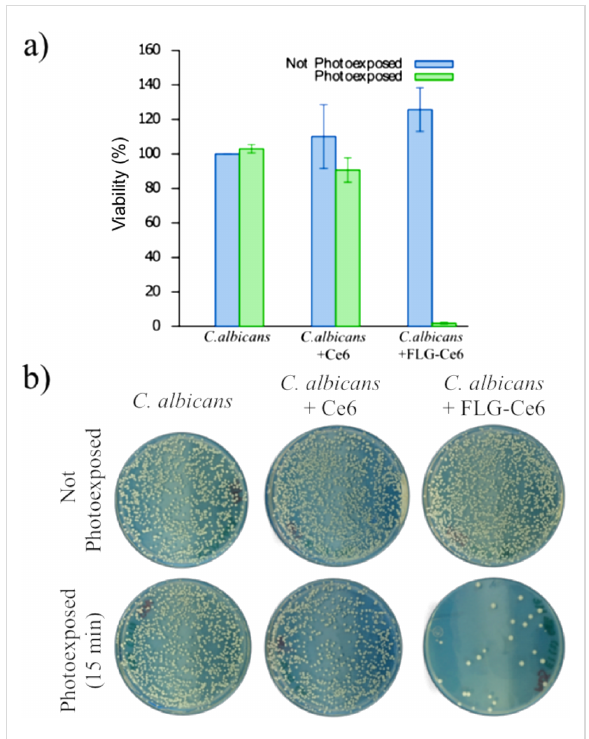
Figure 4: Cell viability assays. a) C. albicans viability 48 h after PDT. The cell cultures were exposed to the FLG-Ce6 hybrid nanomaterial and pristine Ce6 in different trials, and then the samples were photoac- tivated by illumination using the LED designed array for 15 min. b) An image of the colony forming units (CFUs) of C. albicans 48 h after